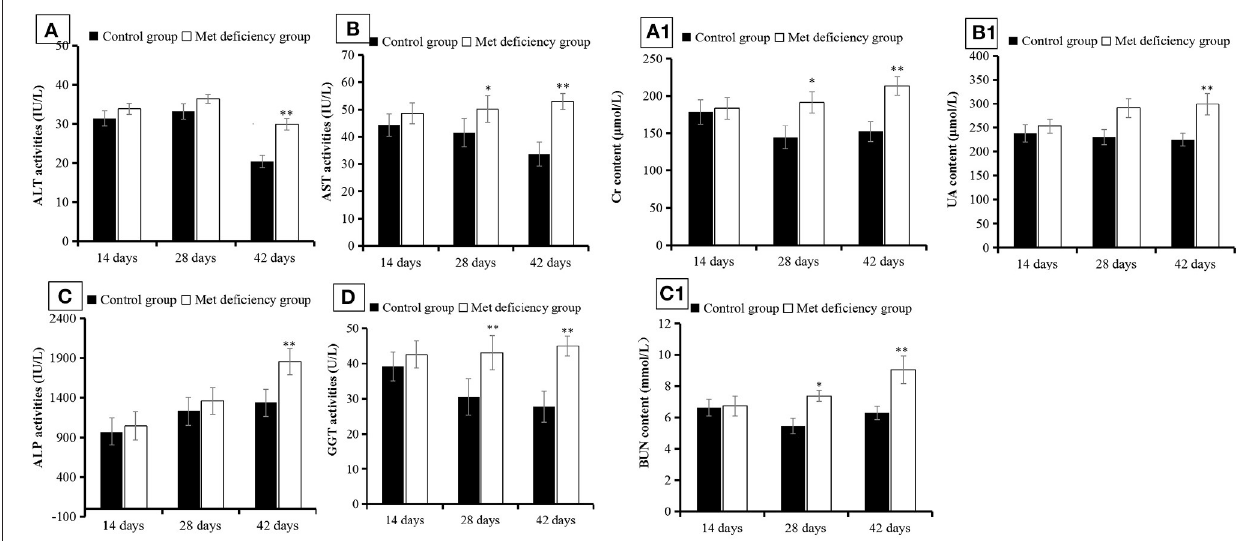
FIGURE 2 | Liver and kidney function detection. The activities of (A) ALT, (B) AST, (C) ALP, and (D) GGT were significantly ( p < 0.05, p < 0.01) increased at 42 days of age in the MD group compared to the control group. Levels of (A1) Cr, (B1) UA, and (C1) BUN were all significantly ( p < 0.05 or p < 0.01) increased at 28 or 42 days of age in the MD group compared to the control group. ALT, alanine transaminase; AST, aspartate transaminase; alkaline phosphatase; GCT, gamma-glutamyl transferase; MD, methionine deficiency; Cr, creatine; UA, uric acid; BUN, blood urea nitrogen.